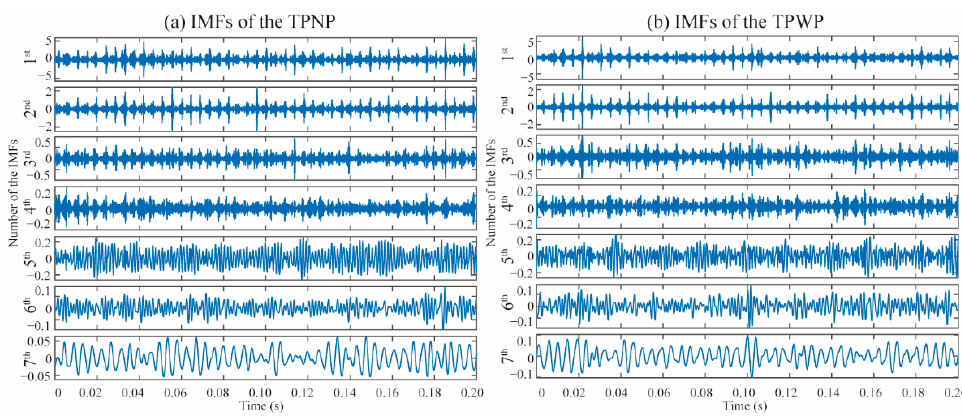
Figure 6. EEMD IMFs. ( a ) TPNP; ( b ) TPWP.